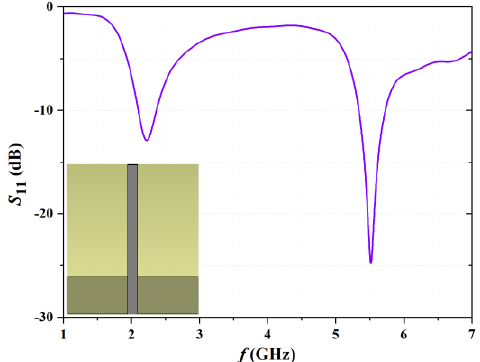
Figure 4. Simulated reflection coefficient of the proposed antenna I in Figure 2 ( L m = 34 mm, W m = 3 mm).